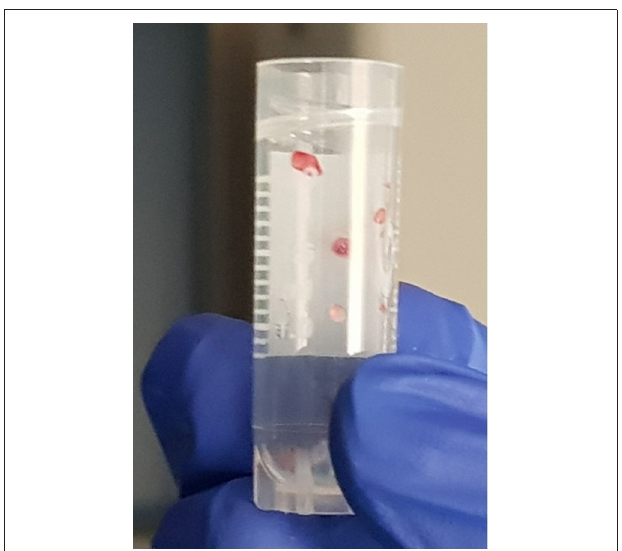
FIGURE 8 | Synovial